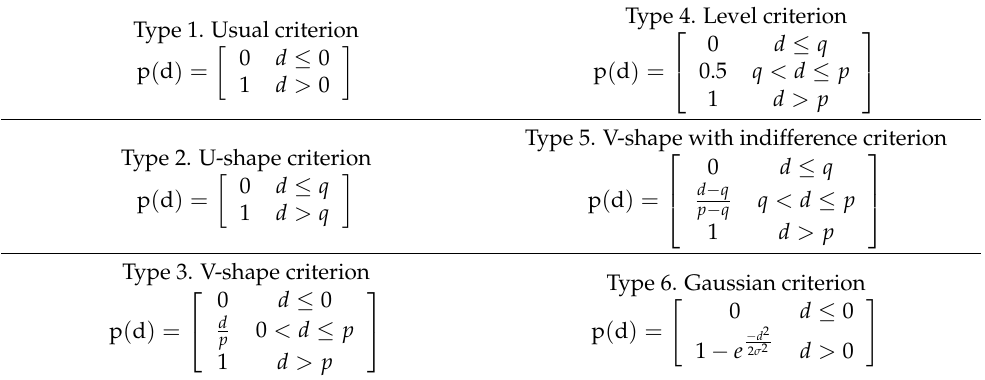
Table 9. Preference function.